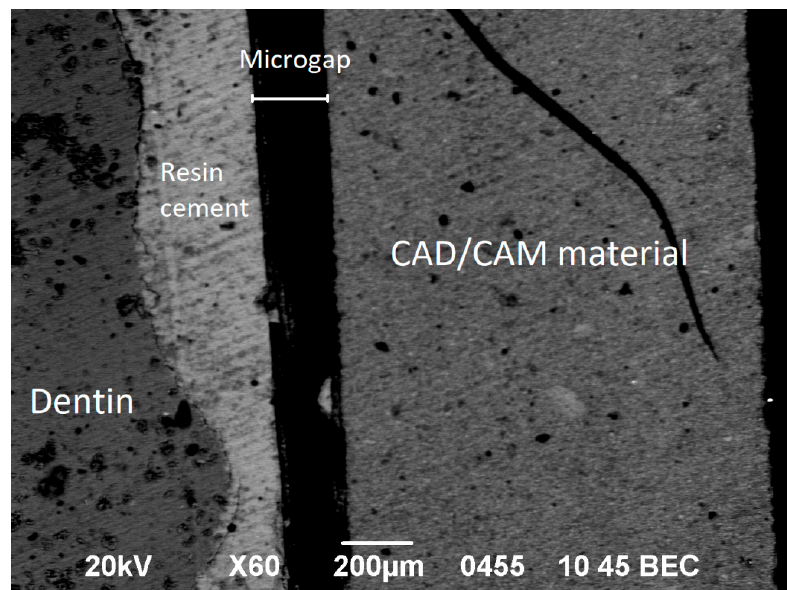
Figure 1. Representative SEM image in backscattered mode for evaluation of the maximum width of the formed microgap in μ m using the software of the microscope.